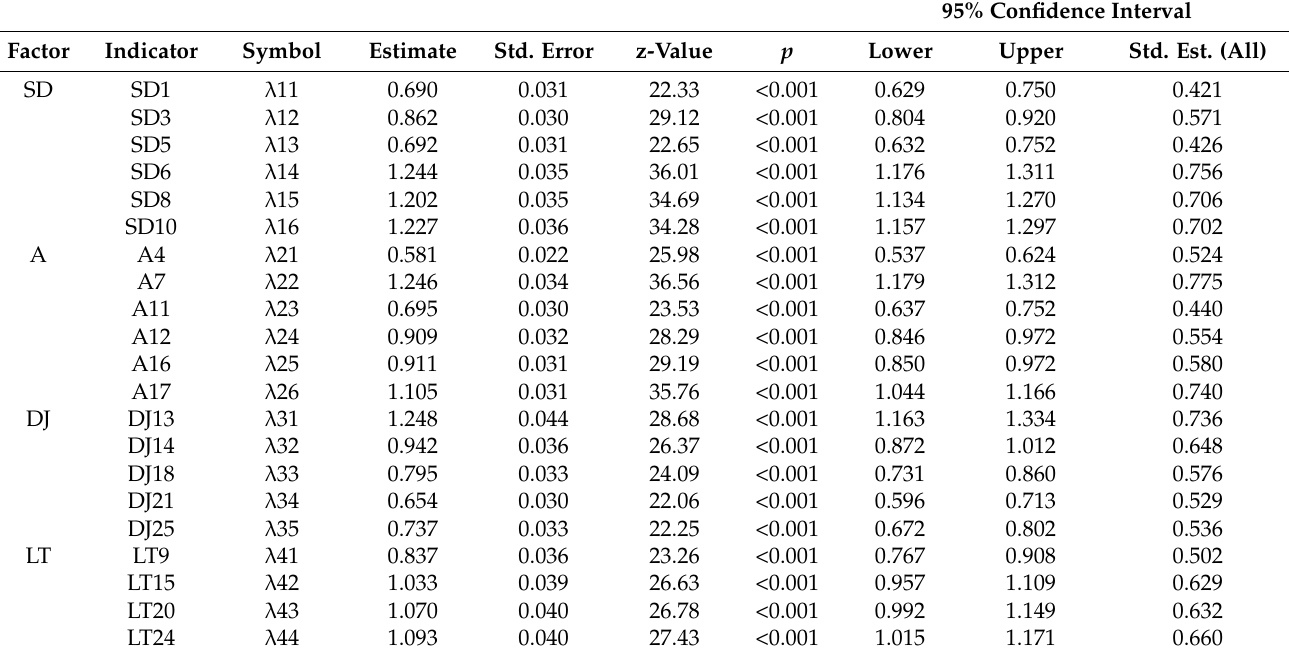
Table 2. CFA measurement model (4-factor): Factors, estimates of factor loadings, standards errors, and statistical significance.